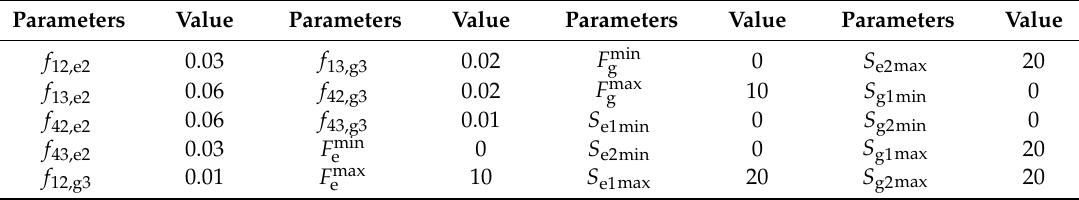
Table 3. Parameters for transmission network